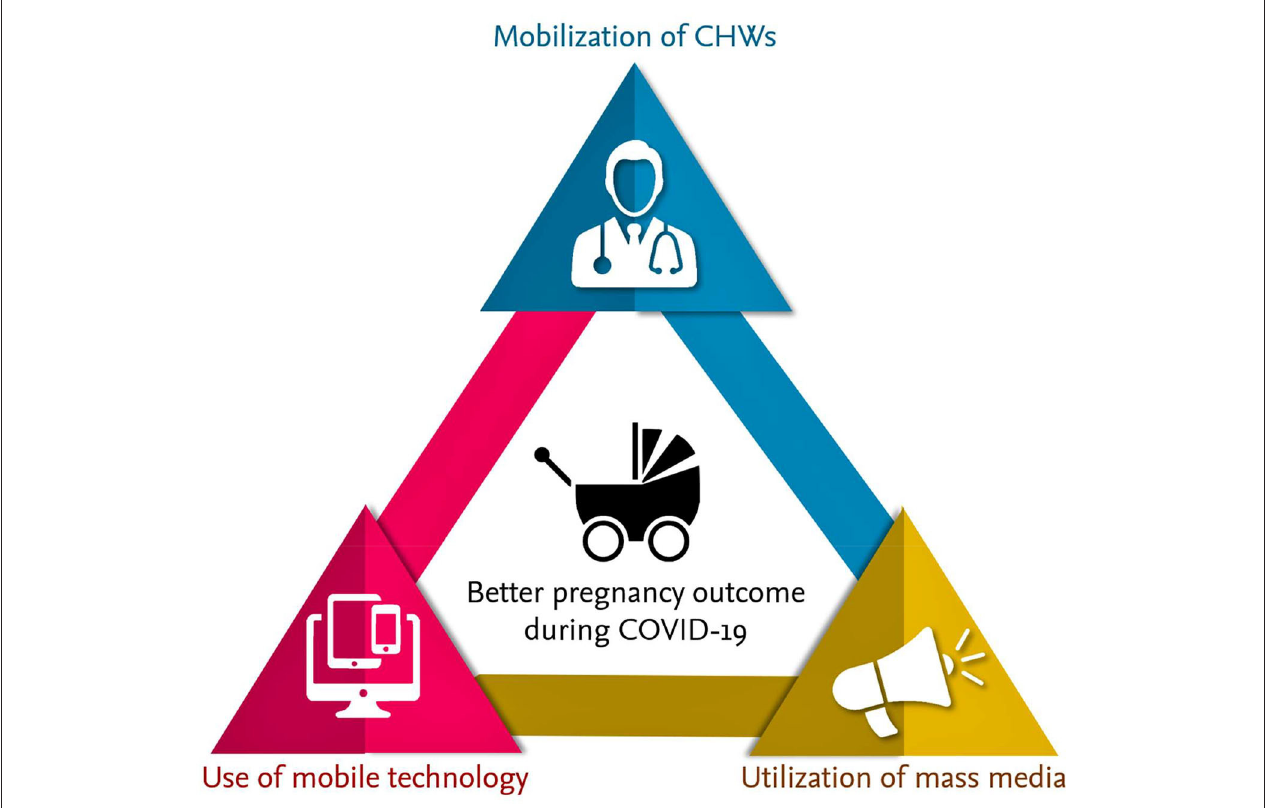
FIGURE 2 | Involvement of CHWs, utilizing mobile healthcare service, and taking advantage of mass media communication on identifying the danger signs during pregnancy could partly mitigate the complications to minimize